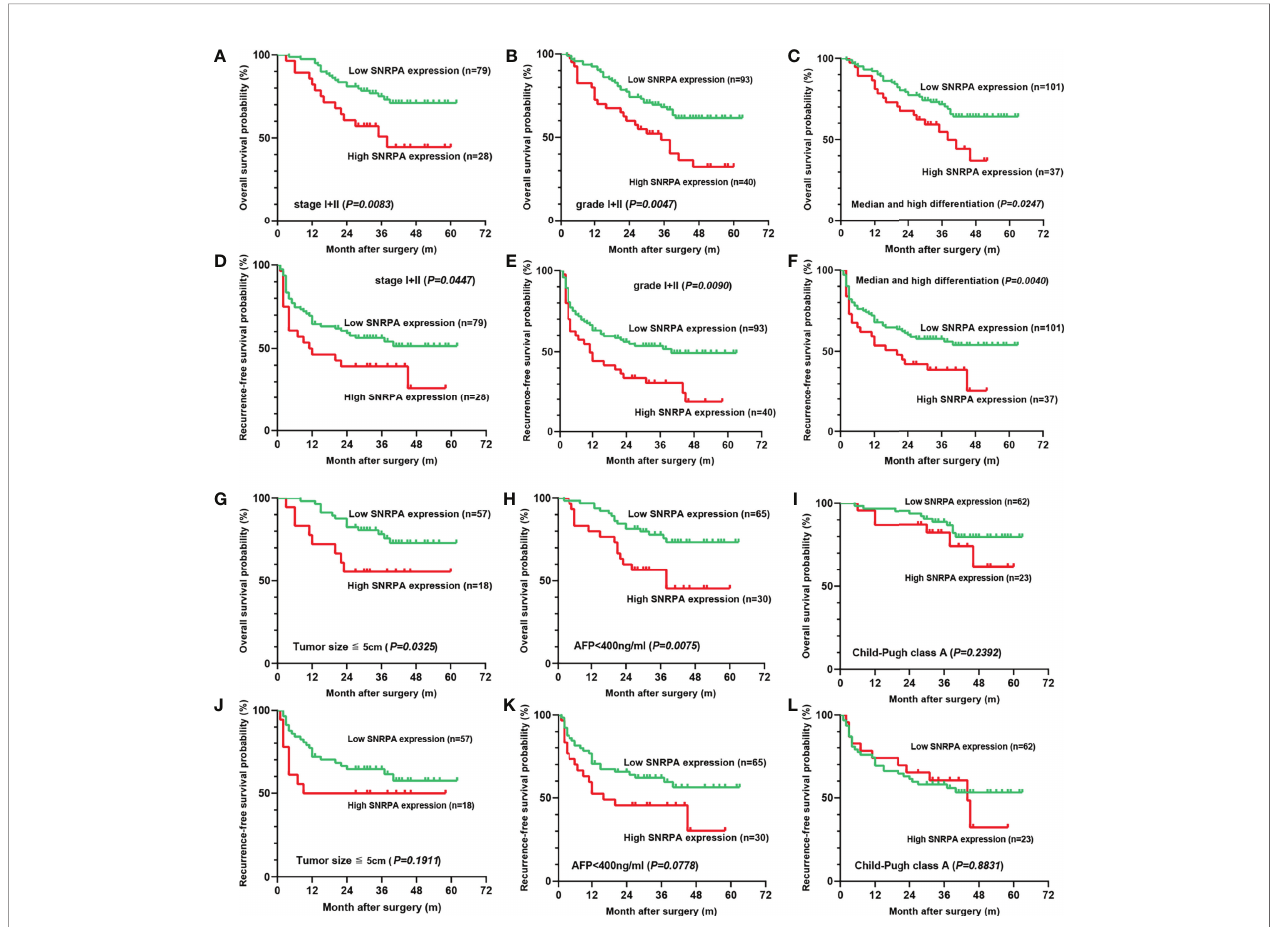
FIGURE 3 | The prognostic value of the SNRPA protein levels in patients with early-stage subgroups. (A – C) In stage I+II (A) , grade I+II (B) , and median/high differentiation subgroups (C) , higher SNRPA protein expression signi fi cantly correlated with shorter OS. (D – F) In stage I+II (D) , grade I+II (E) , and median/high differentiation subgroups (F) , higher SNRPA protein expression signi fi cantly correlated with shorter RFS. (G, H) In tumor size ≤ 5cm (G) , AFP ≤ 400 ng/ml (H) subgroups, higher SNRPA protein expression correlated with poor OS. (I) There was no correlation between the SNRPA protein expression and OS in the Child-Pugh class A subgroup. (J – L) In tumor size ≤ 5cm (J) , AFP ≤ 400 ng/ml (K) , and Child-Pugh class A (L) subgroup, RFS did not signi fi cantly differ between the high and low SNRPA protein expression